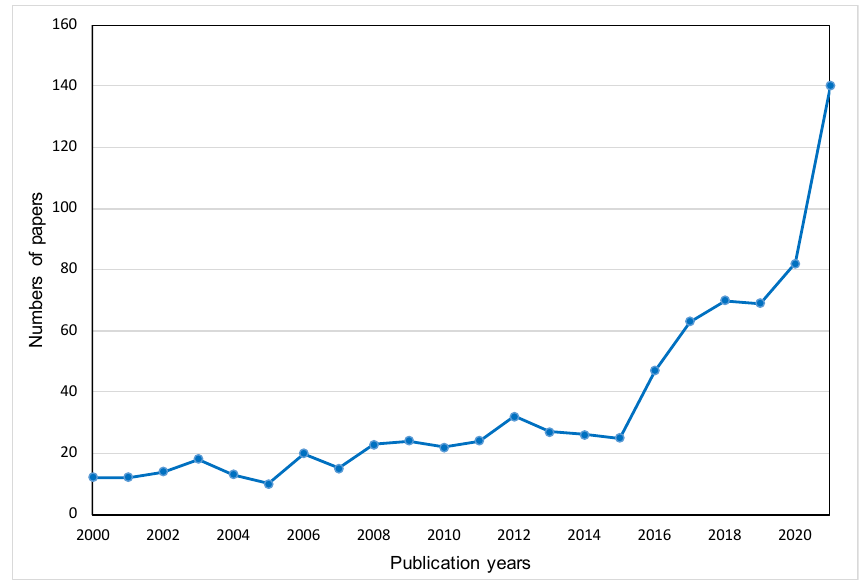
Figure 1. The trends of annual publications from 2000 to 2021.